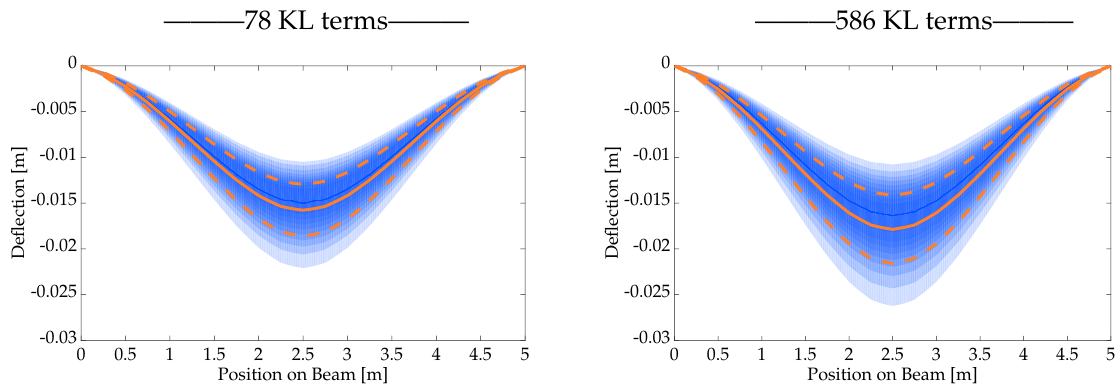
Figure 18. Uncertainty propagation towards the QoI’s for model problem